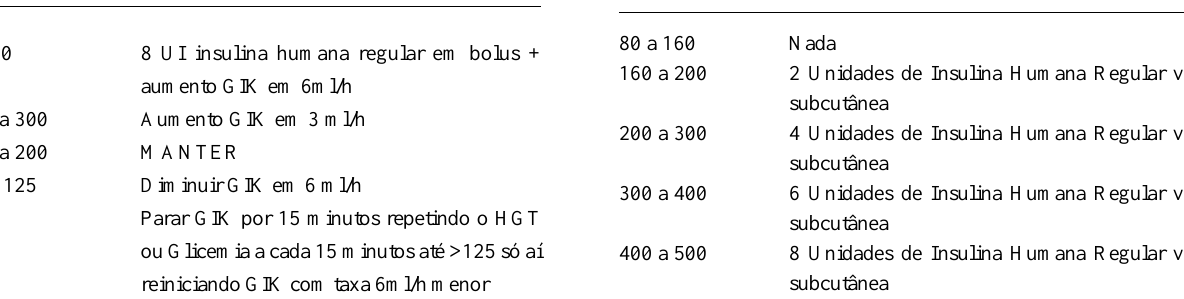
Tabela 1. Escala para ajuste da infusão de GIK (intervenção) Glicemia (mg/dl)